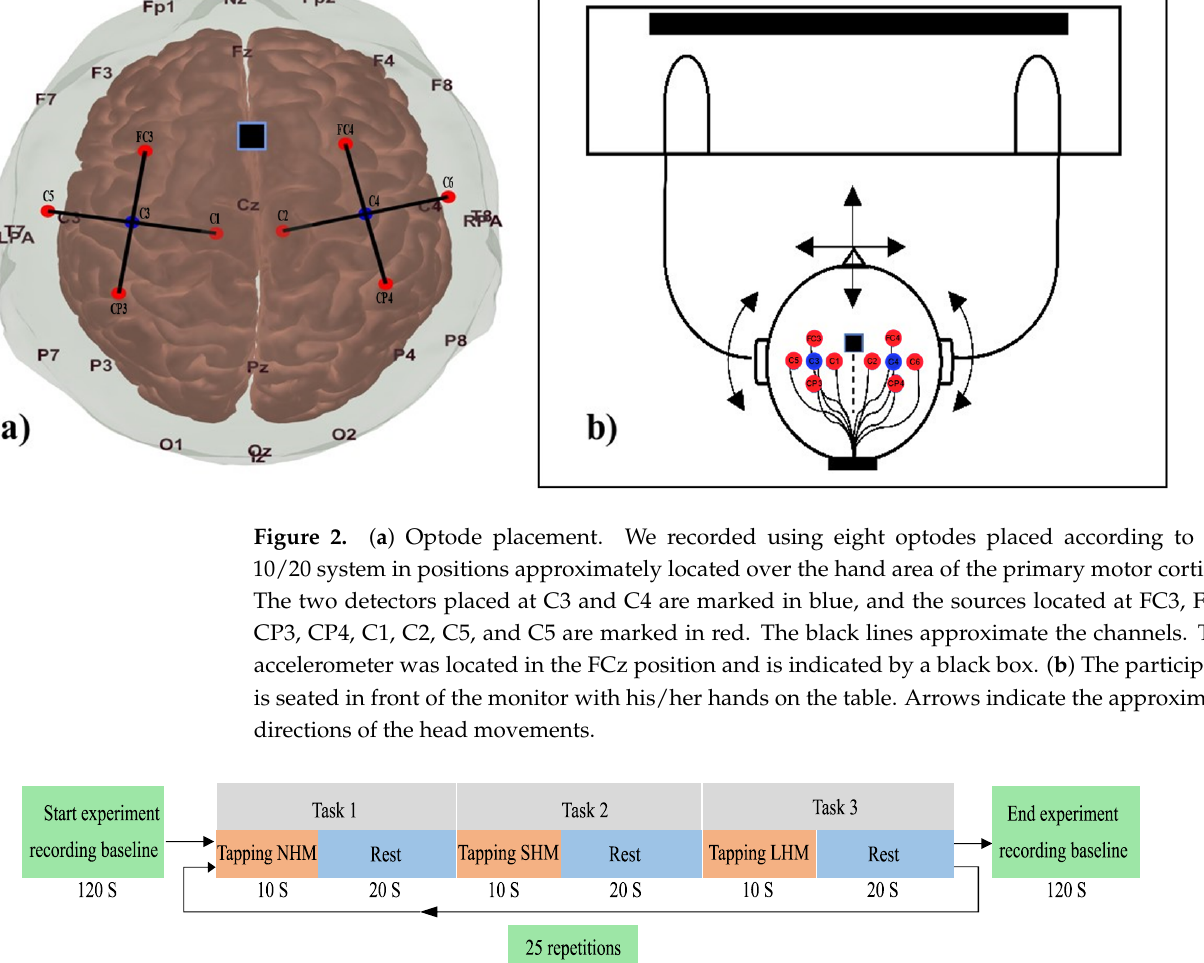
Figure 2. ( a ) Optode placement. We recorded using eight optodes placed according to the 10/20 system in positions approximately located over the hand area of the primary motor cortices. The two detectors placed at C3 and C4 are marked in blue, and the sources located at FC3, FC4, CP3, CP4, C1, C2, C5, and C5 are marked in red. The black lines approximate the channels. The accelerometer was located in the FCz position and is indicated by a black box. ( b ) The participant is seated in front of the monitor with his/her hands on the table. Arrows indicate the approximate directions of the head movements.